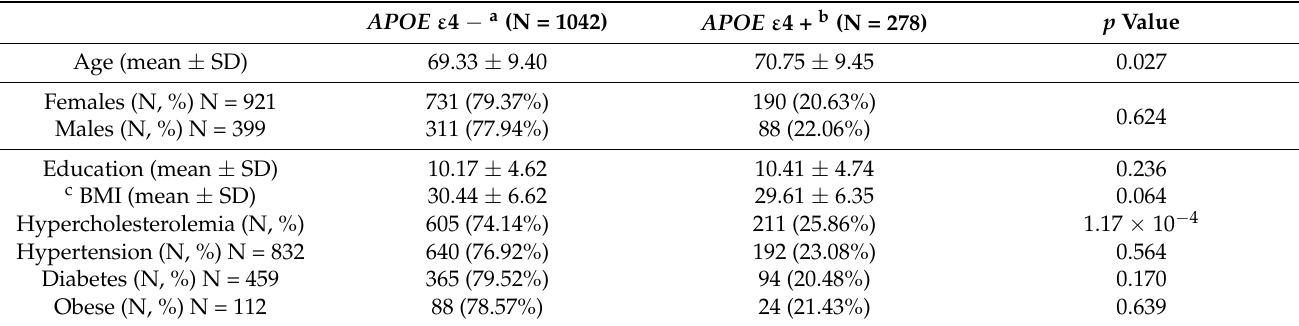
Table 3. APOE ε 4 allele status on demographics and cholesterol related phenotypes in our studied population.